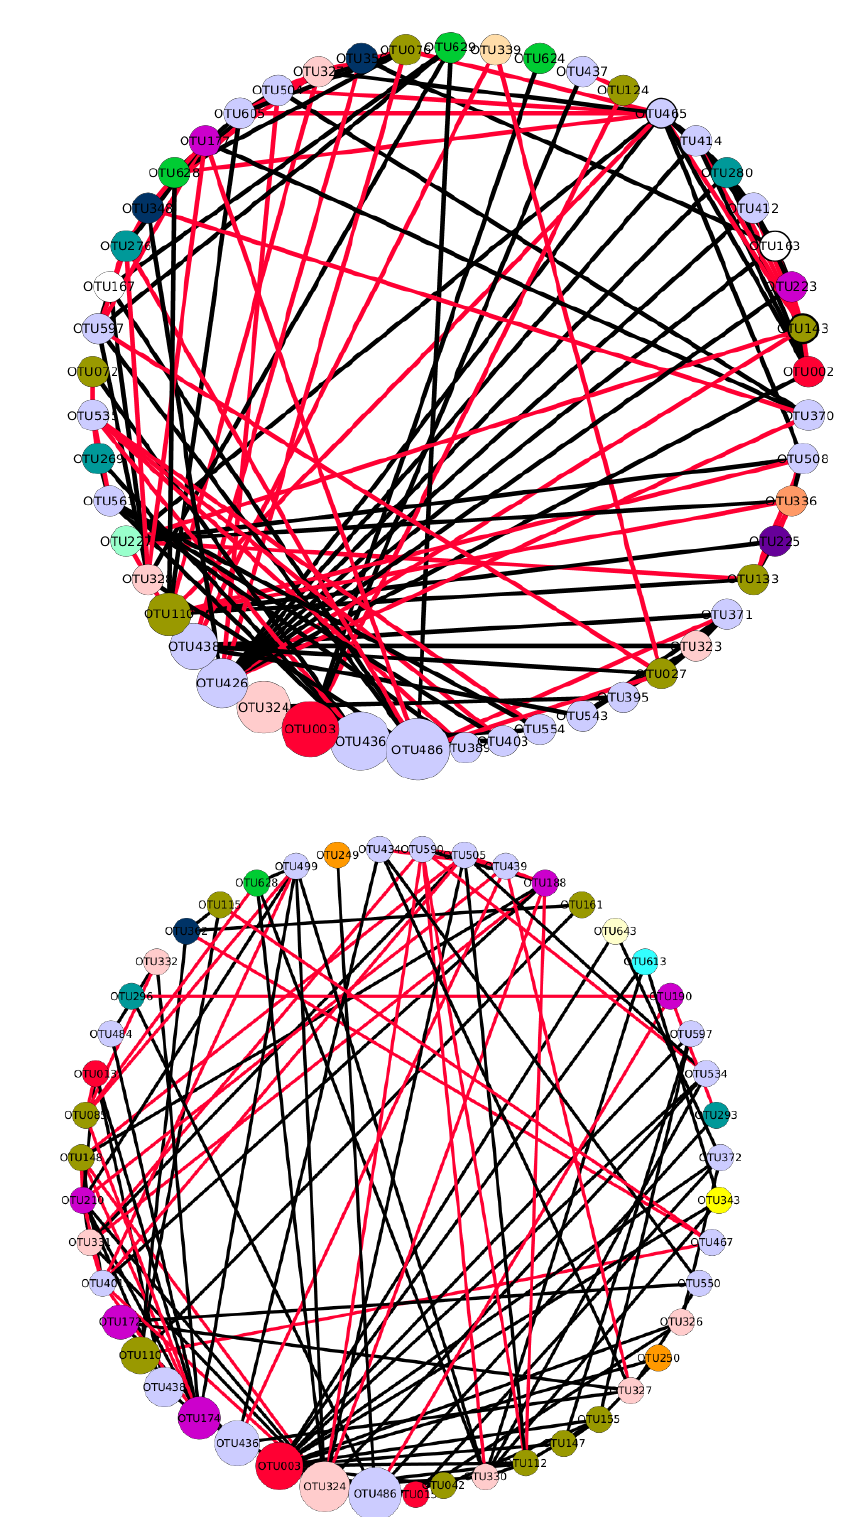
Figure 2. Subnetwork of the eight most abundant OTUs and their first neighbor nodes in the ( A ) conventional cropping system (Conv) and both organic cropping systems, ( B ) Org_C and ( C ) Org_M. Each circle represents an OTU, and its color represents a phylum. The size of the circle corresponds to the OTU’s abundance; OTUs are arranged so that they neighbor OTUs of similar size. Red and black lines represent negative and positive